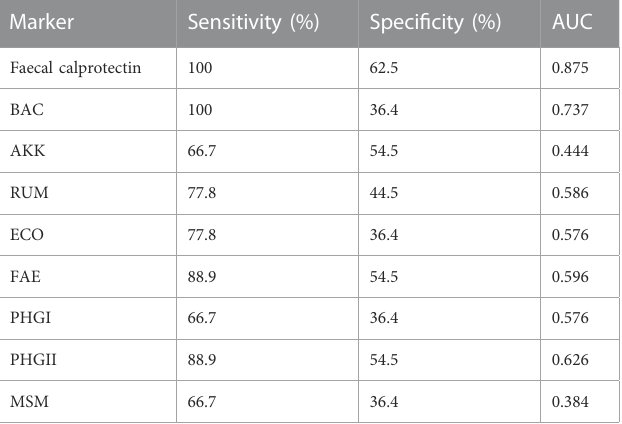
TABLE 3 Sensitivity, speci fi city, and area under the curve (AUC) for faecal calprotectinandrelativeabundanceofBacteroidetes(BAC), A.muciniphila (AKK), Ruminococcus spp. (RUM), E. coli (ECO), F. prausnitzii (FAE) and its two pyhlogroups (PHGI and PHGII), and M. smithii